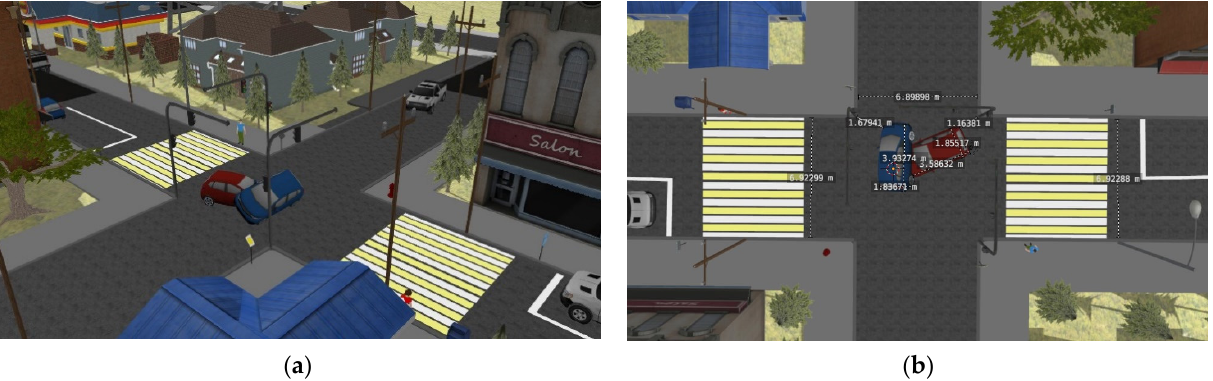
Figure 15. Scenes in Gazebo containing accidents and reference distances between objects: ( a ) illus- trates a model of an accident scene, ( b ) shows hand-measured distances in a photograph of an accident scene.